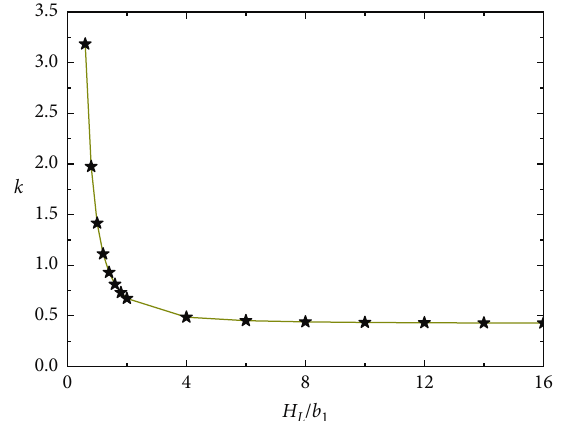
Figure 20: Buckling coefficient of the plate strip.